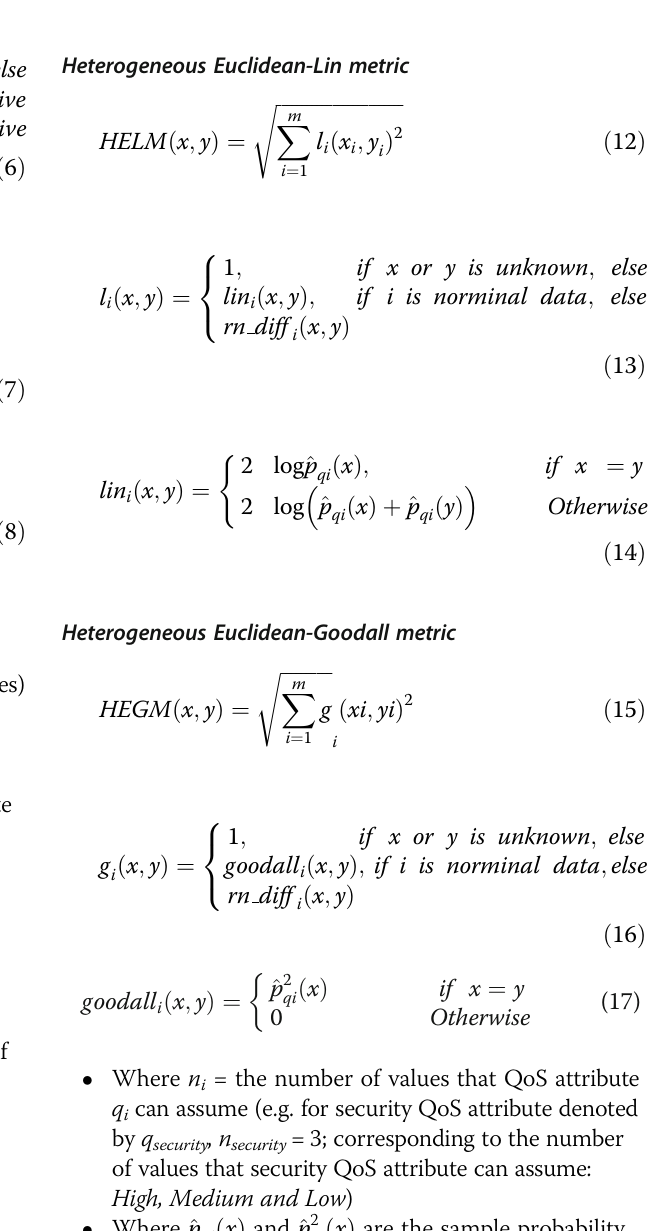
ffiffiffiffiffiffiffiffiffiffiffiffiffiffiffiffiffiffiffiffiffiffiffiffiffiffi X m